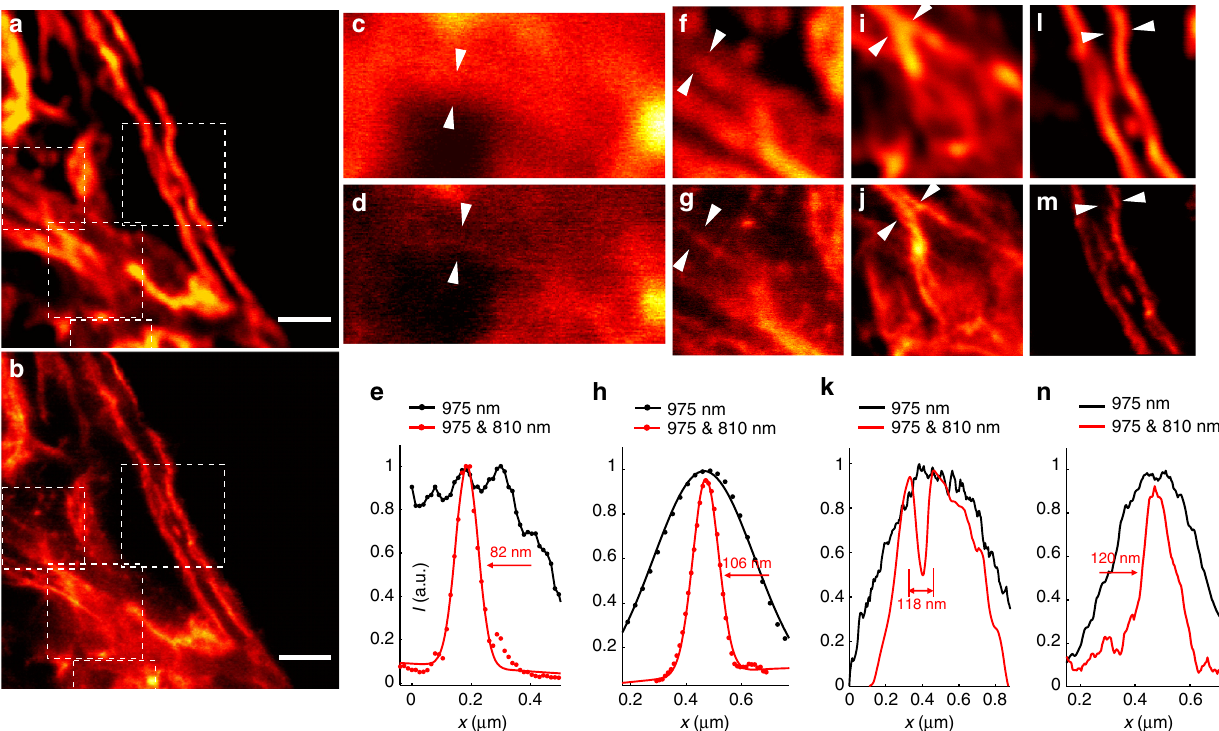
Fig. 4 Immuno fl uorescence labeling of cellular cytoskeleton protein desmin with antibody-conjugated UCNPs and super-resolution imaging. a The multiphoton imaging under 975-nm excitation of some cytoskeleton structures and desmin proteins in HeLa cancer cells incubated with anti-desmin primary antibody and immunostained with UCNPs (11.8 ± 2.2 nm in diameter) bioconjugated with goat anti-rabbit IgG secondary antibody. b The same region with a imaged in the super-resolution mode (975-nm excitation and the 810-nm STED laser beam). Scale bars: 2 μ m. c – n Magni fi ed areas selected from a and b (marked by white dotted squares) and line pro fi le analyses; images in c , f , i , and l are taken from the white dotted squares in a ; Images in d , g , j , and m are taken from the white dotted squares in b . e , h , k , n Line pro fi les analyses of several areas indicated by arrow heads in c and d , f and g , i and j , and l and m ,